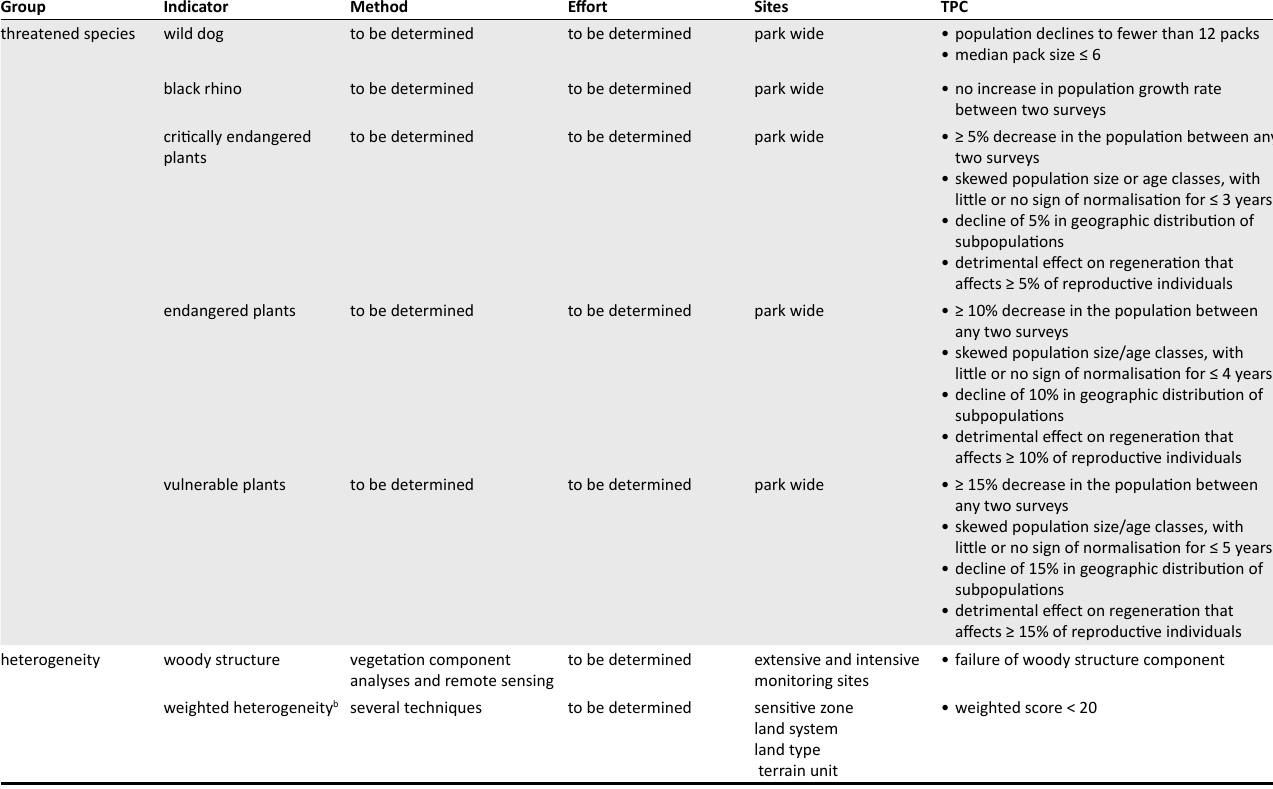
TABLE 2: Thresholds of potential concern, with a species focus or components with a species focus, as revised for the Kruger National Park in 2007. a